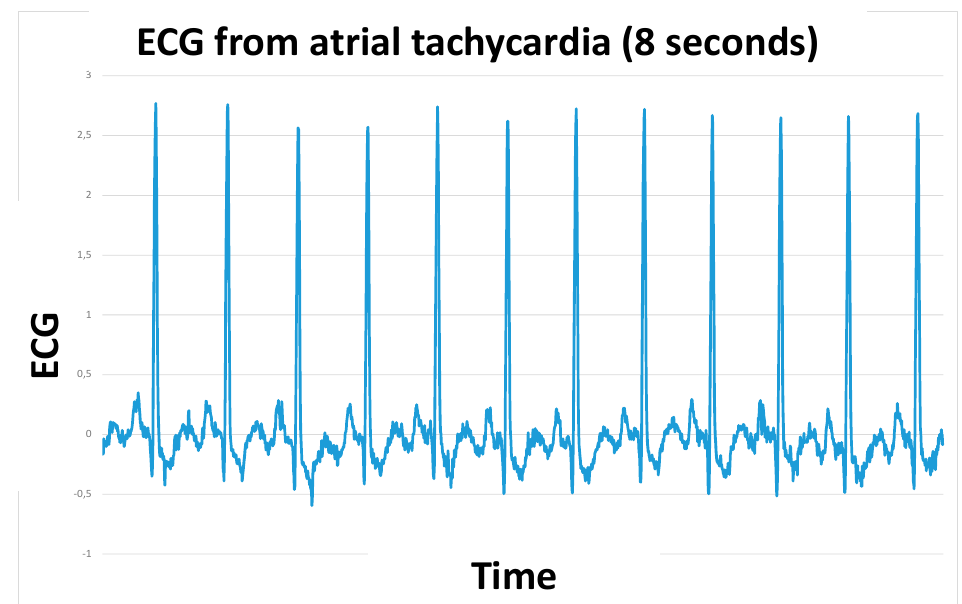
Figure 4. Examples of ECG signals (a single derivation is included for brevity) for a time window of 8 s in the pathology of atrial flutter and atrial